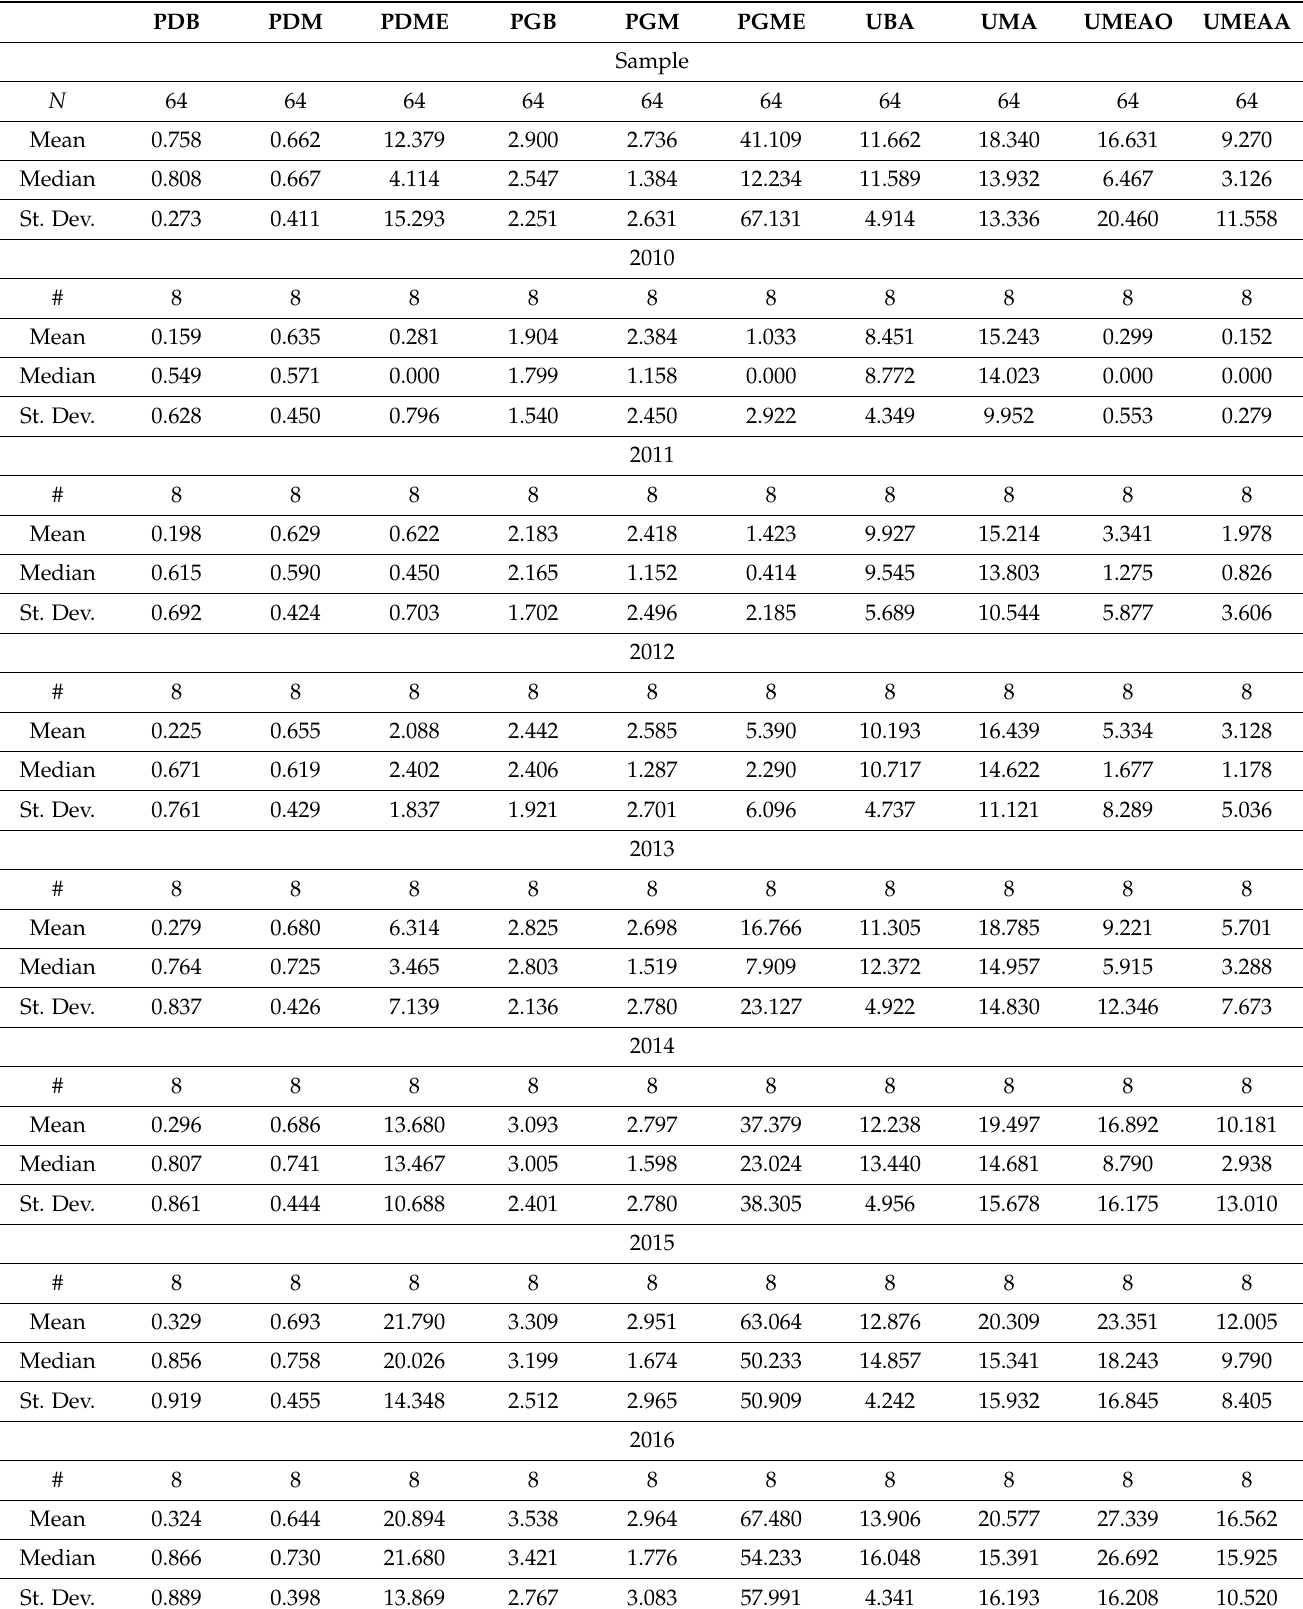
Table 3. Descriptive analysis of the